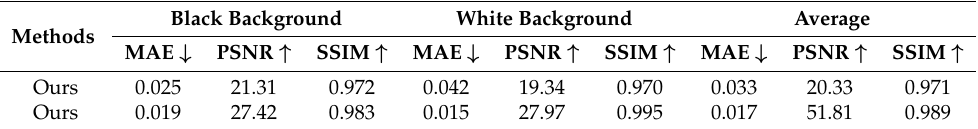
Figure 4. Qualitative colorization results of the prostate T2-weighted MRI using different image colorization approaches. Table 2. Performance comparison between using refined foreground maps and coarse foreground maps. ↑ denotes higher the better and ↓ represents lower the